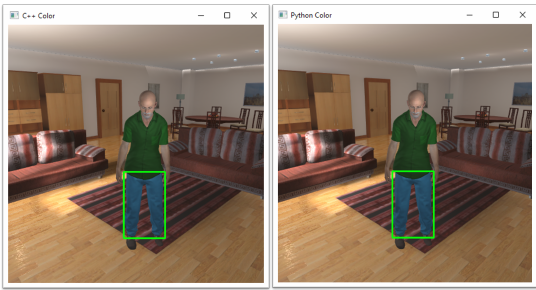
Figure 6. Colour detection results in C++ and Python.